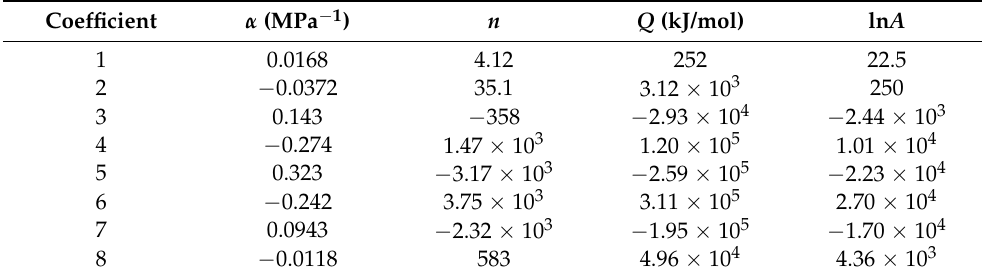
Table 3. 7th-order polynomial coefficients of material constants α , n , Q , ln A . Coefficient